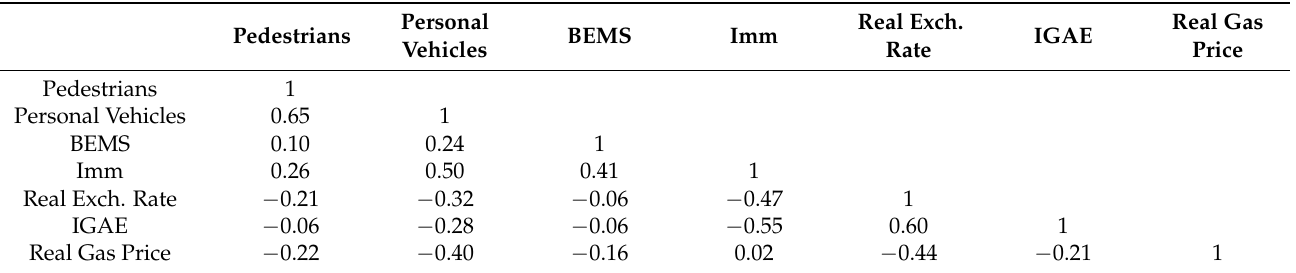
Table 3. Correlation